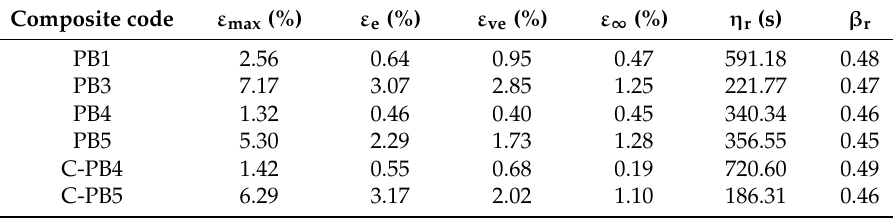
Table 3. Parameters of the Weibull distribution function—recovery phase of composites.